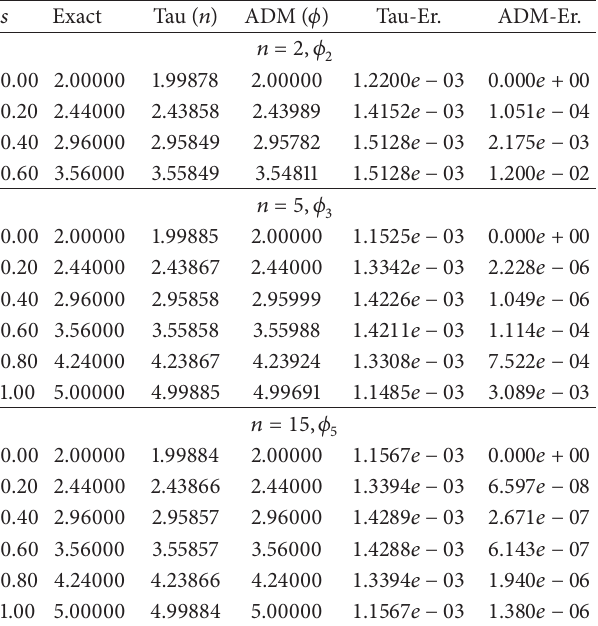
Table 1: Numerical results for Problem